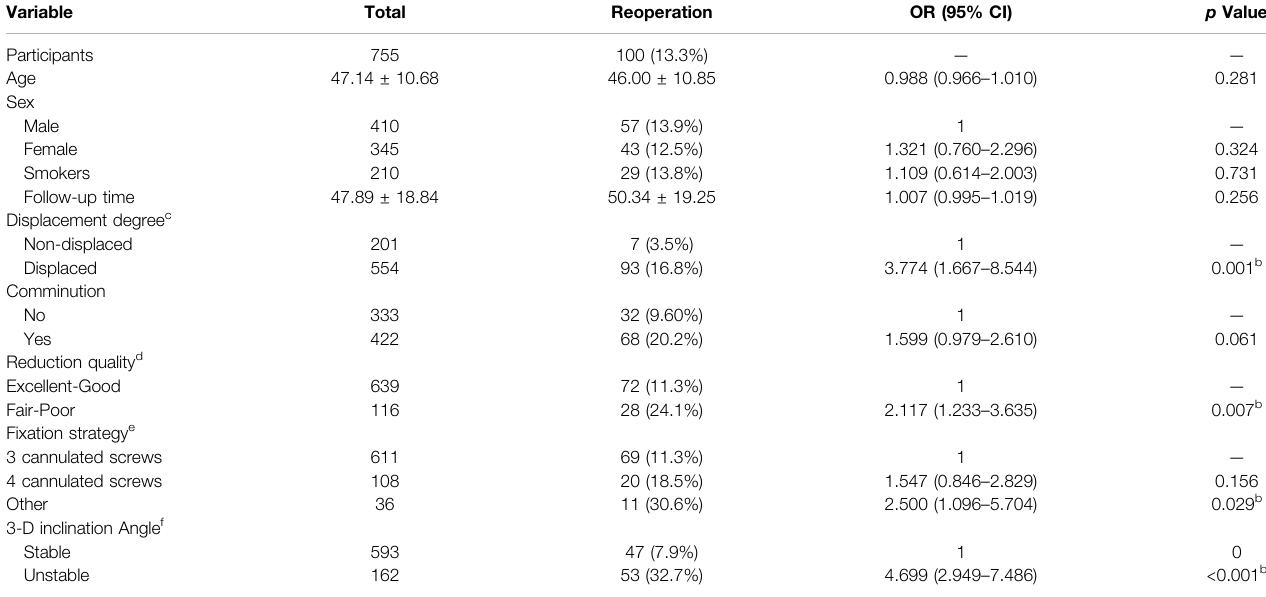
TABLE 1 | Demographic and selected clinical characteristics of the study population.